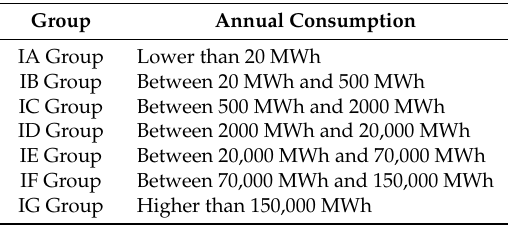
Table 9. Classification of industrial consumers, electricity. Source: Eurostat.